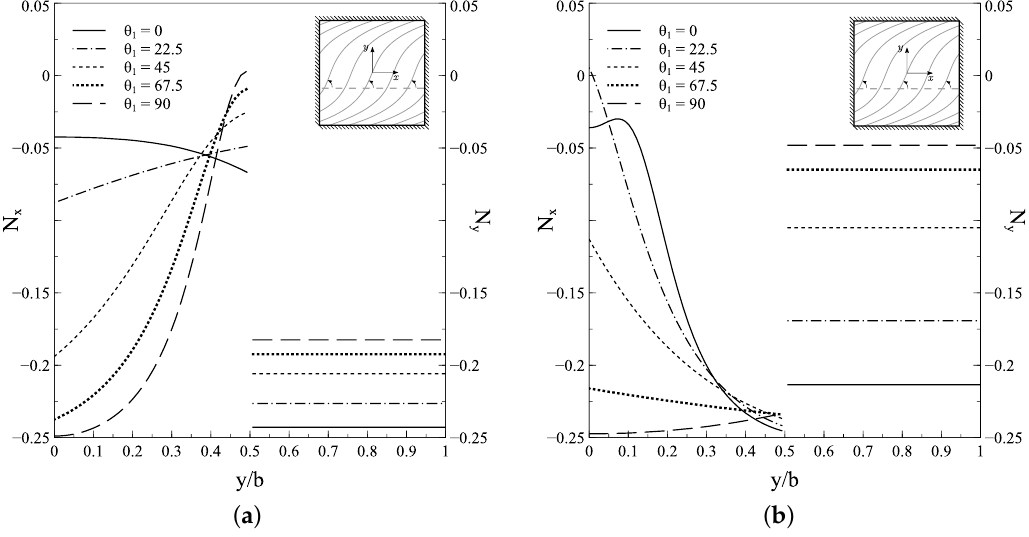
Figure 6. Pre-buckling membrane resultants for [ ± < θ 0 | θ 1 > y ] s laminates subjected to Case-Ty1 conditions: ( a ) θ 0 = 15; ( b ) θ 0 =